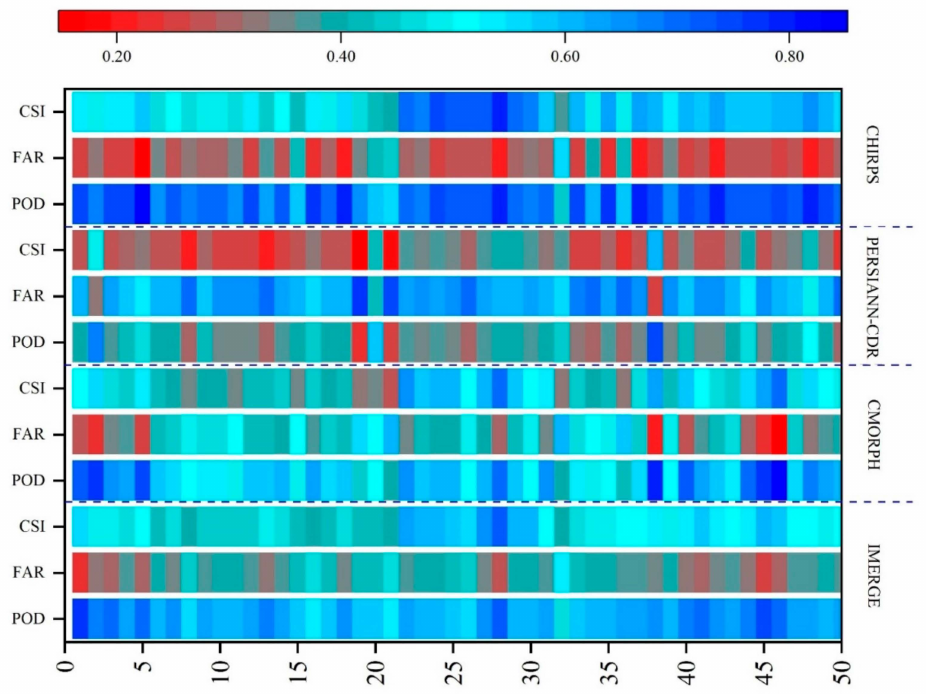
Figure 7. Heat map showing the contingency measures for each product. The X-axis shows the number of stations. POD stands for Probability of Detection, FAR denotes False Alarm Ratio, and CSI represents Critical Success